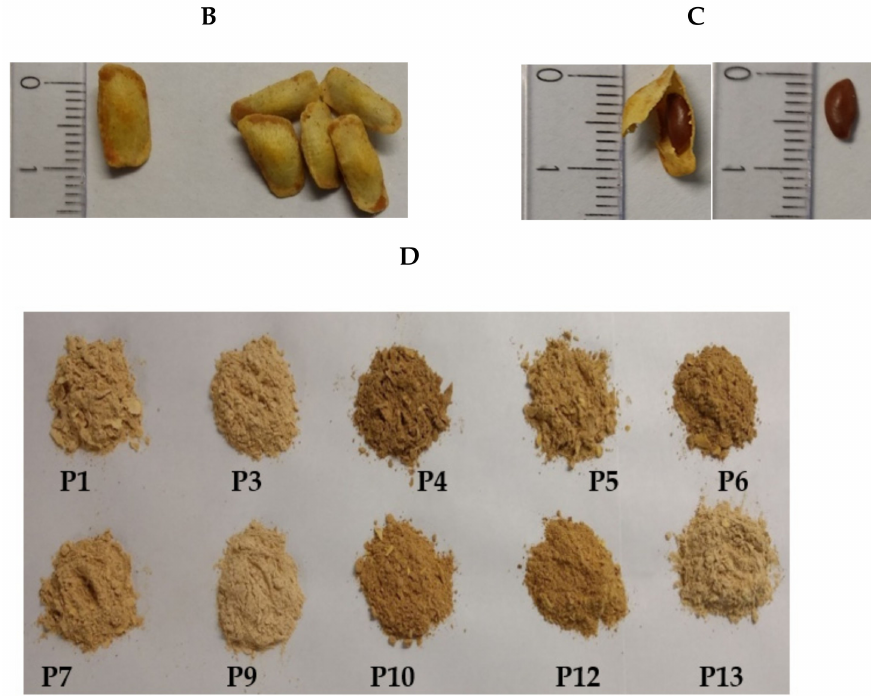
Figure 1. ( A ) Flowchart of the methodology. ( B ) Seeds with endocarp. ( C ) Seeds and ( D ) flour of seeds from 10 clones of Prosopis alba